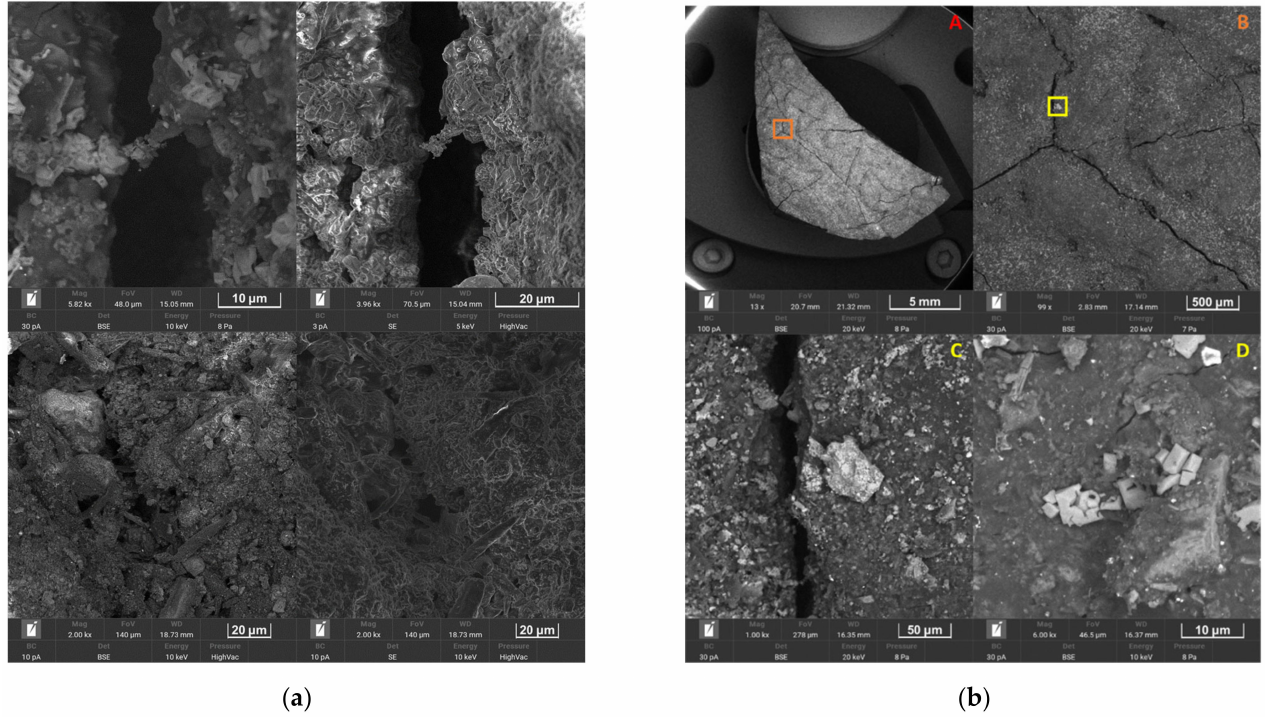
Figure 6. ( a ) SEM images of samples S1 ( top ) and S3 ( bottom ) obtained from back scattering ( left ) and secondary electrons ( right ). For each sample, the left and right panels correspond to the same region. ( b ) SEM images collected from sample S1 overall ( A ), maginification of the region delimited by the orange square ( B ) and two details in the region within the yellow square ( C , D